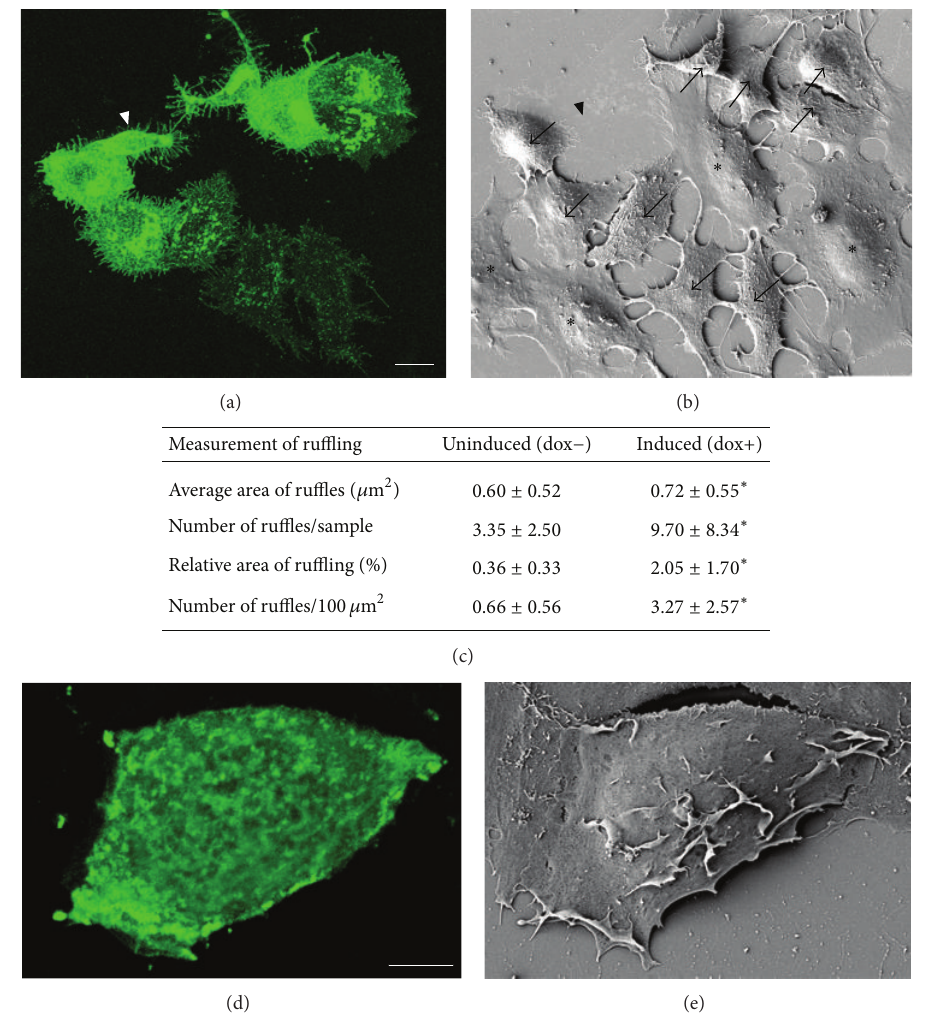
Figure 3: GFP-HAS3 expression induces plasma membrane ruffling. Confocal 3D projection of transiently transfected MCF-7 cells imaged by CLSM (a) and the corresponding area by SEM (b). Arrows in (b) indicate GFP-HAS3-positive cells with plasma membrane ruffling, while negative cells (asterisks) have smoother dorsal surface. Arrowheads in (a) and (b) indicate a cell that was lost during SEM processing. Stable, inducible transfections were utilized to quantify the dorsal ruffling of MCF-7 cells, which was significantly increased upon induction of GFP- HAS3. Significant difference ( 𝑃 < 0.05 ) in quantified parameters of ruffling is indicated by an asterisk ( ∗ ) in table (c). 𝑁 = 20 in both groups. A GFP-HAS3-positive cell treated with hyaluronidase before fixation is shown with CLSM and SEM in (d) and (e), respectively. Scale bars 10 𝜇 m in (a) and 5 𝜇 m in